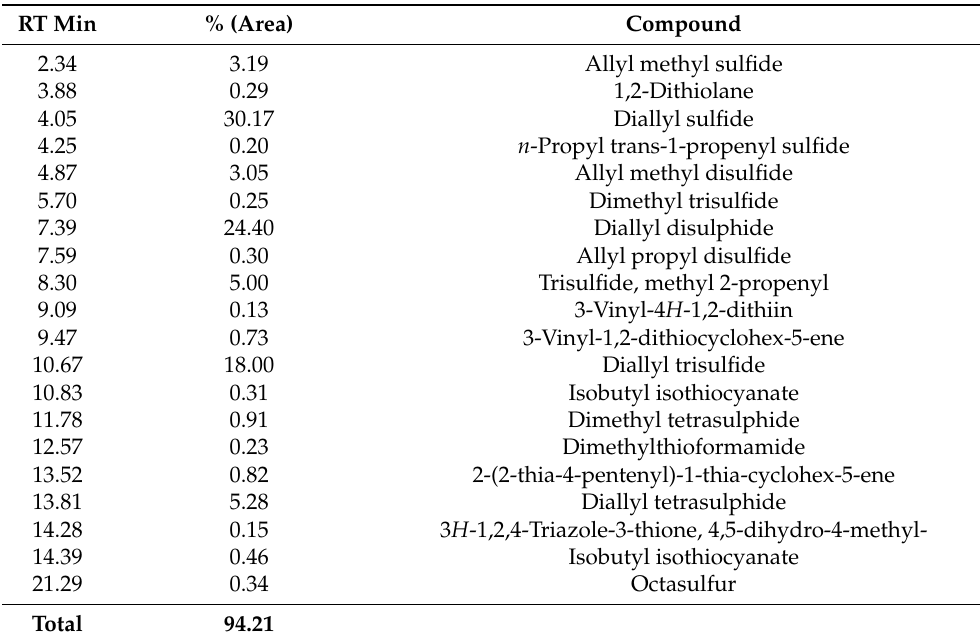
Table 2. Chemical compositions of garlic